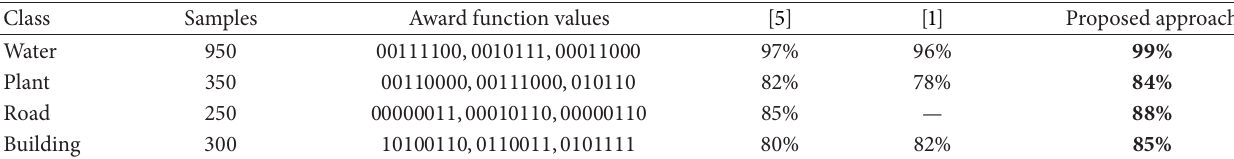
Table 2: Comparison of results for the proposed